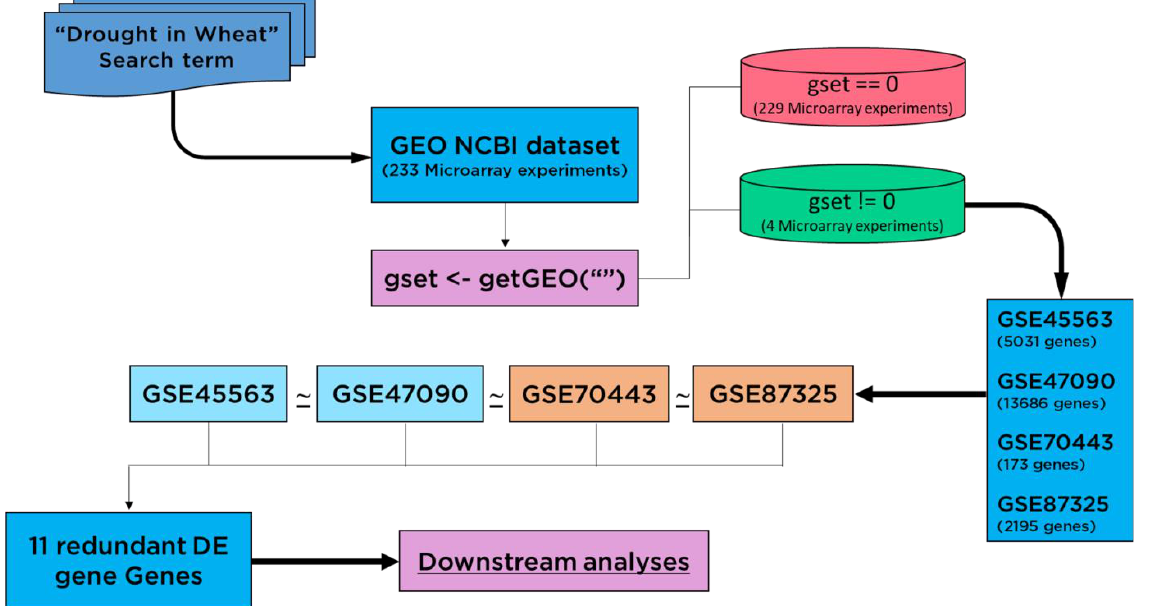
Figure 1. Flow chart diagram shown for screening of differentially expressed (DE) genes. Redundant genes were collected using expression datasets which were differentially expressed in each dataset.